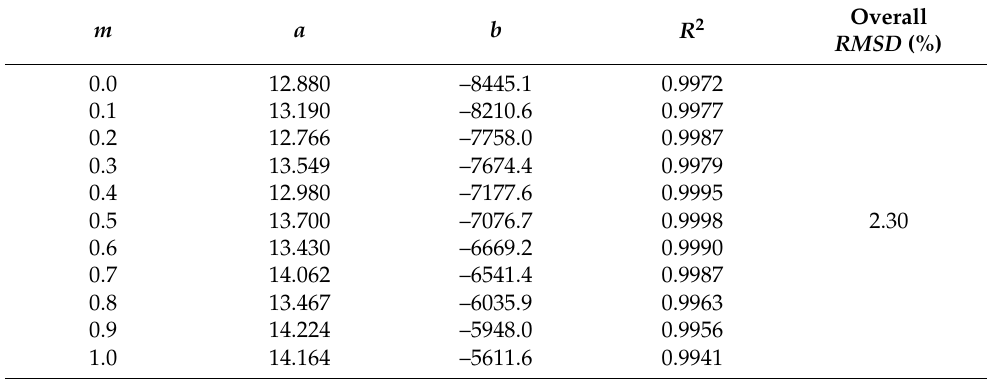
Table 5. Results for the van’t Hoff model for FXT (3) in several {PEG 400 (1) + H 2 O (2)} combinations.